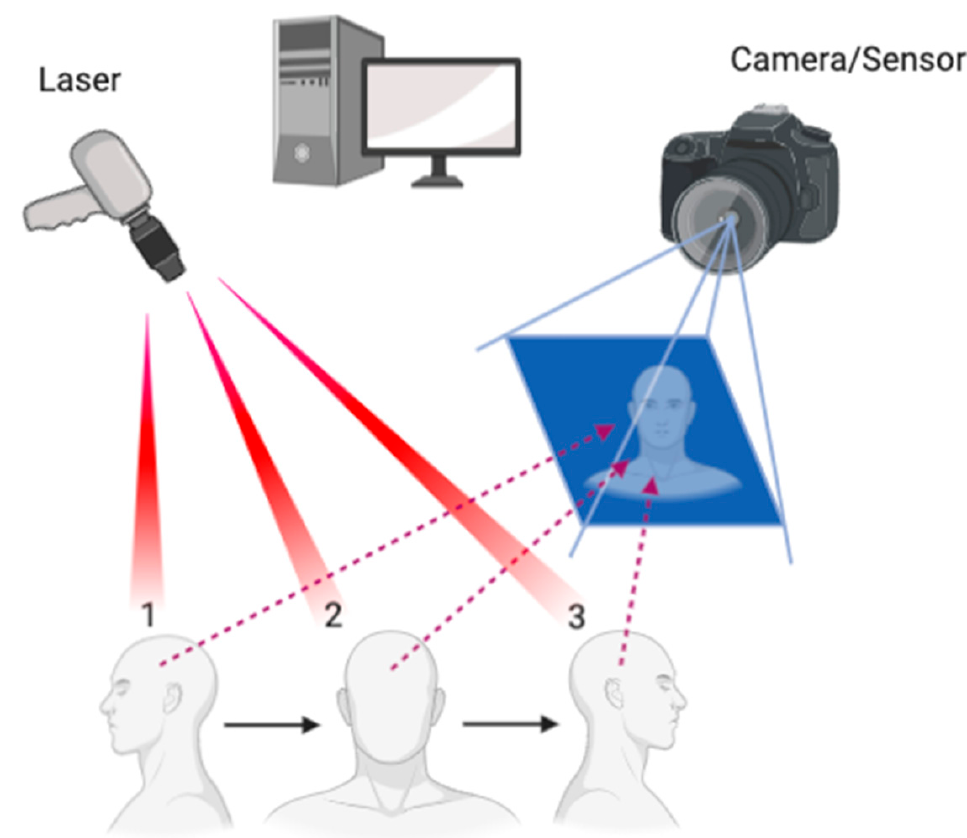
Figure 4. Laser scanners record the subject in multiple positions by taking scans of multiple posi- tions. These scans are then picked up by a camera and computed into one image by a computer algorithm. Location of the laser and the camera can be located on a single device, depending on the manufacturer.